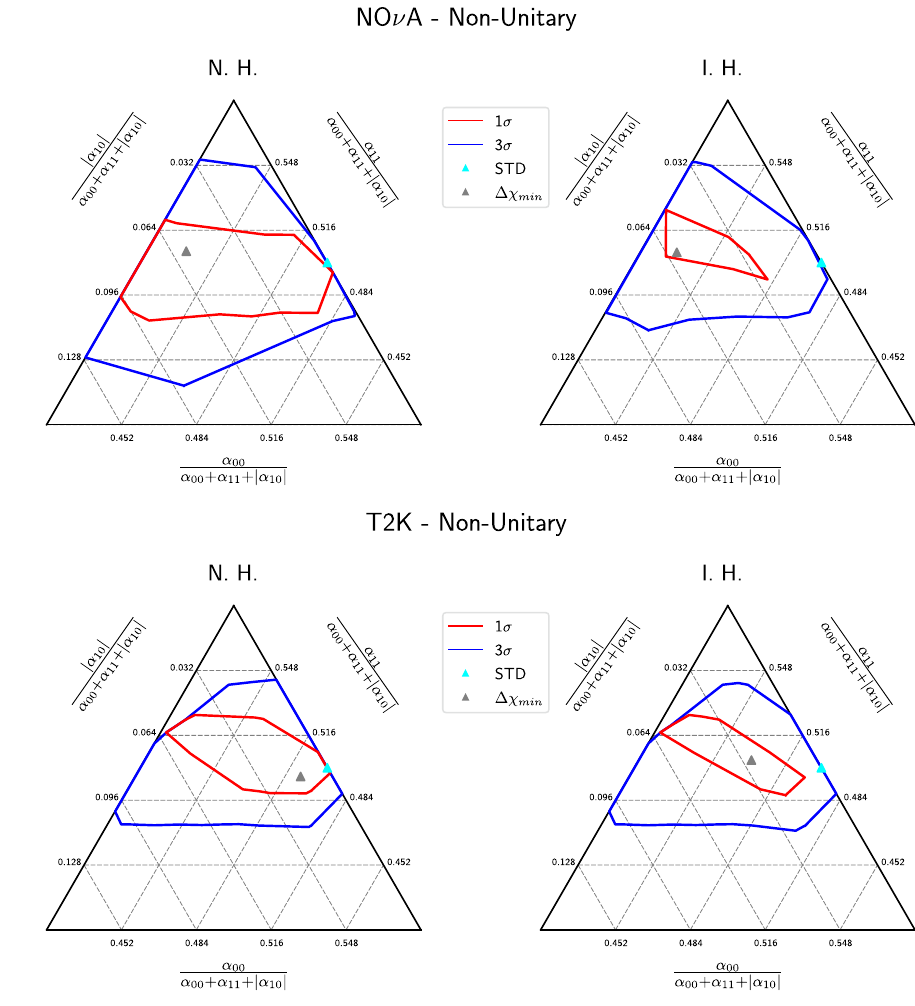
Fig. 10 Allowed regions of the α parameters in a triangle plot for NO ν A (T2K) in the upper (lower) panel. The left (right) panel is for NH (IH). The parameter values at the best fit point are listed in Table 1 (2) for NO ν A (T2K). These results are for 2019